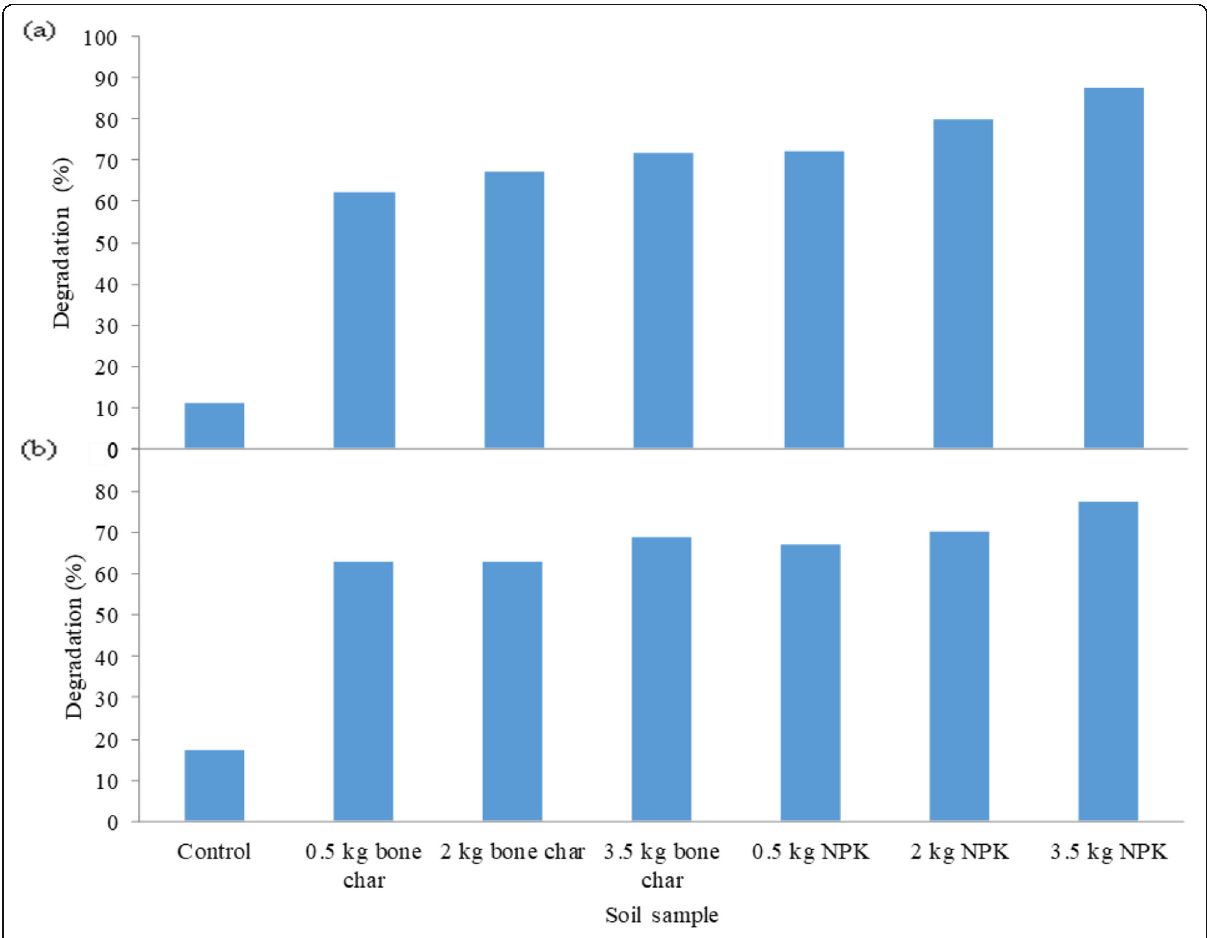
Fig. 3 Degradation of (a ) THC ( b )